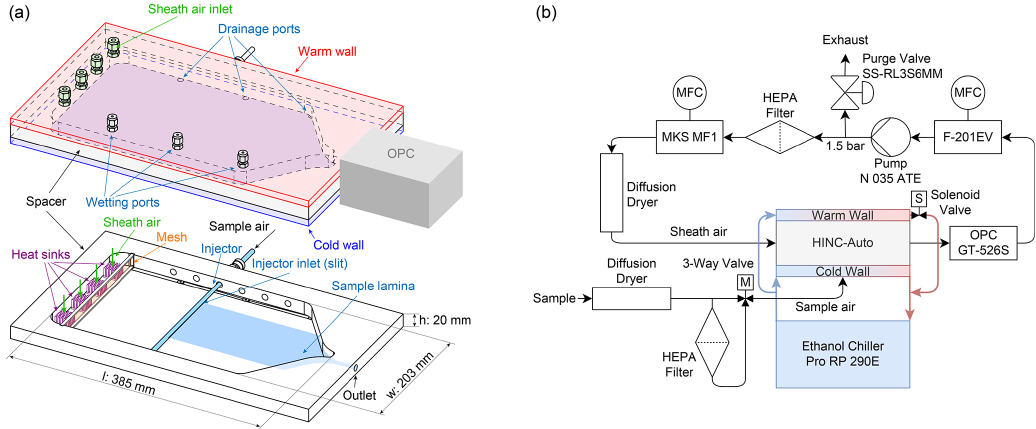
Figure 2. A schematic of HINC-Auto: (a) the entire chamber and the internal parts (bottom). (b) External components and flow setup.